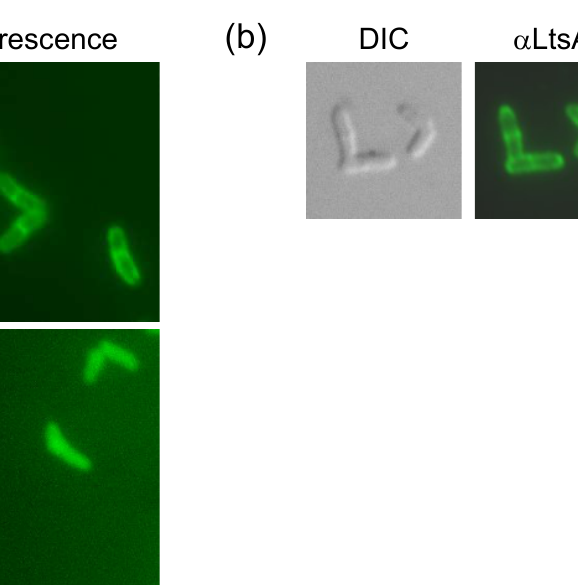
Figure 1. Intracellular localization of LtsA protein in C. glutamicum cells. ( a ) Fluorescent microscopic observation of C. glutamicum expressing ltsA-gfp fusion gene. Differential interference contrast (DIC) microscopy images and fluorescence microscopy images observing GFP or LtsA-GFP fusion (Fluorescence) in C. glutamicum cells are shown. For observation of localization of GFP and LtsA-GFP fusion, C. glutamicum KY9714 carrying plasmids with LtsA-GFP fusion (LtsA-GFP) and GFP alone (GFP) were used, respectively. A bar represents 2 µ m. ( b ) Indirect immunofluorescence microscopic observation of intracellular localization of LtsA protein in C. glutamicum . DIC image and detection image of LtsA by anti LtsA